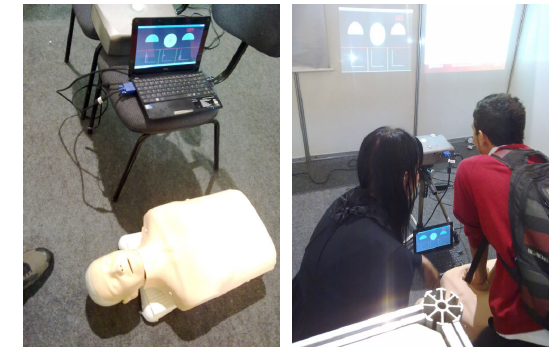
Figure 5. CPR system setup (left) and being used